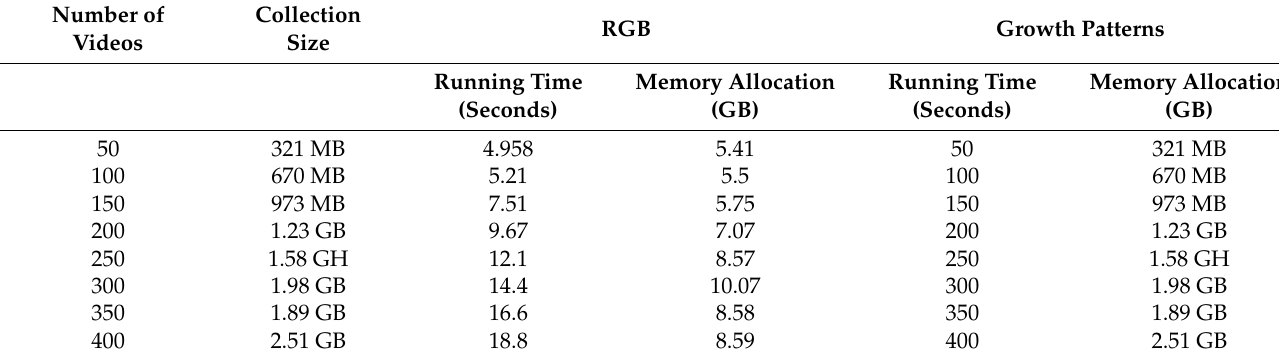
Table 8. Incremental Analysis for Computer Resources